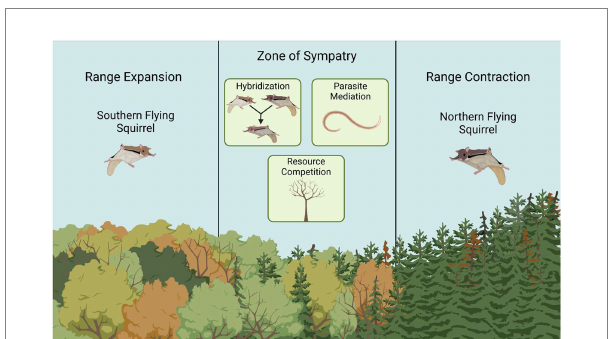
FIGURE 2 Southern flying squirrels (SFS; Glaucomys volans ) and northern flying squirrels (NFS; Glaucomys sabrinus ) exhibit geographic range overlap in the Appalachians, New England, and the Great Lakes Region